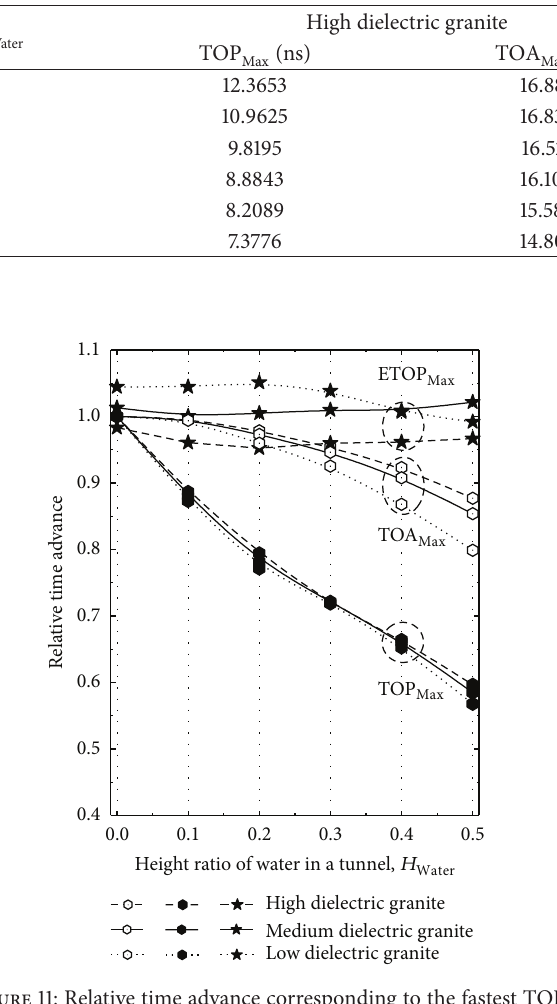
Figure 11: Relative time advance corresponding to the fastest TOP (TOP Max ), the fastest TOA (TOA Max ), and the fastest TOP with enhancement (ETOP Max ) by considering the low, medium, and high dielectric properties of